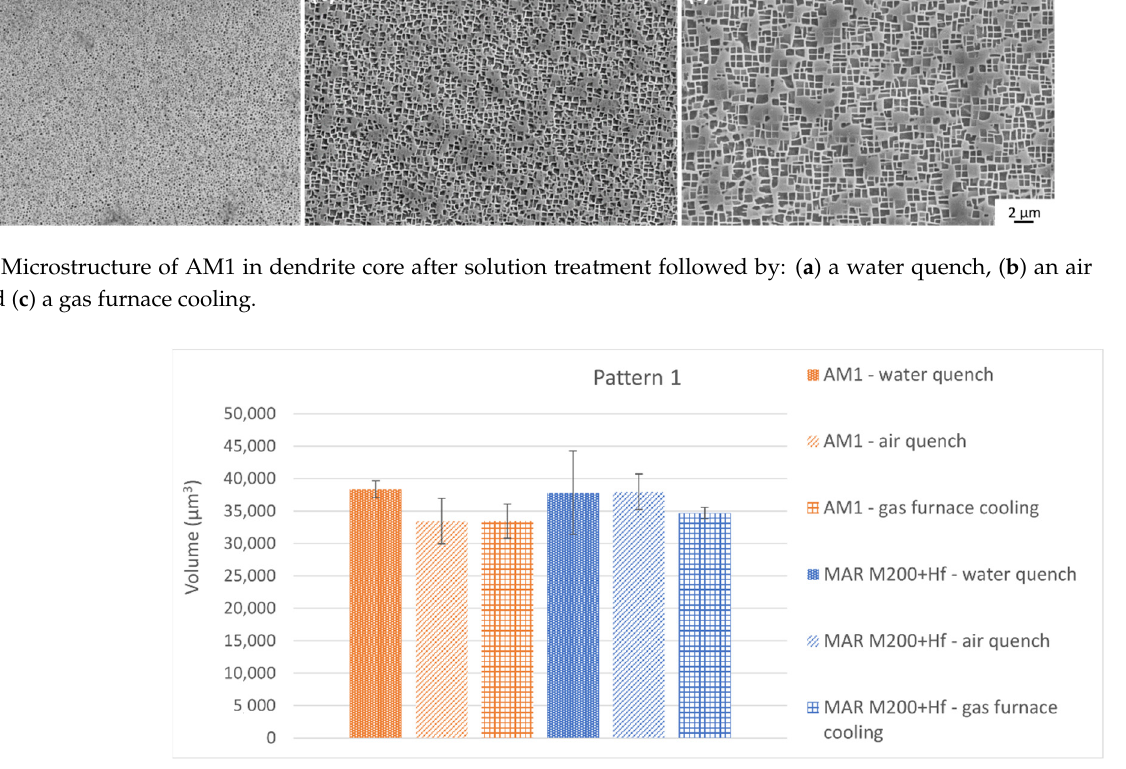
Figure 11. Microstructure of AM1 in dendrite core after solution treatment followed by: ( a ) a water quench, ( b ) an air quench and ( c ) a gas furnace cooling.